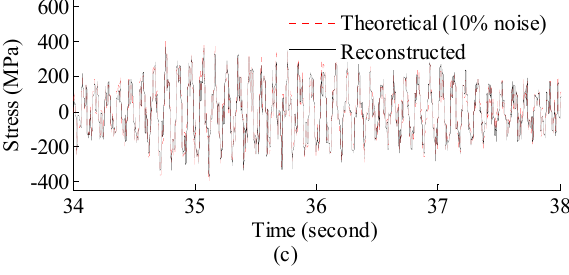
Figure 7. Reconstructed and theoretical bending stress responses for the location of interest under ( a ) 2%; ( b ) 5%; ( c ) 10% noise level. Results are concentrated on 34–38 s for clear presentation.